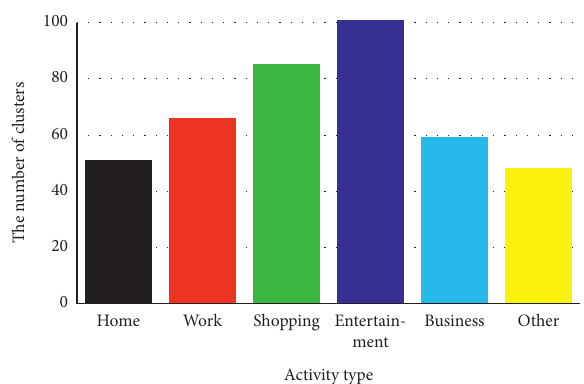
Figure 10: Cluster number distribution related to different activity